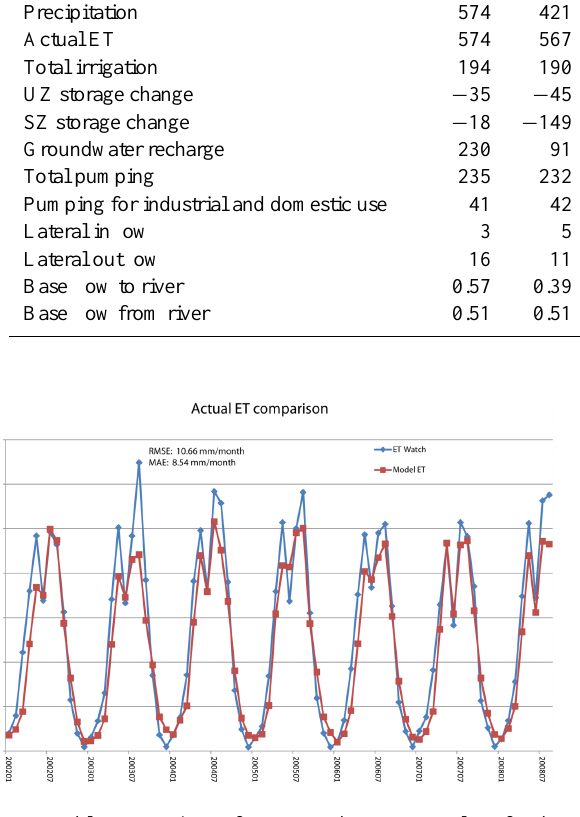
Fig. 7. Monthly comparison of aggregated mean ET values for the Fig.7. Monthly comparison of aggregated mean ET values for the entire model domain. 1027 entire model domain. RMSE and MAE values given are based on RMSE and MAE values given are based on linear regression analysis. 1028 linear regression analysis.